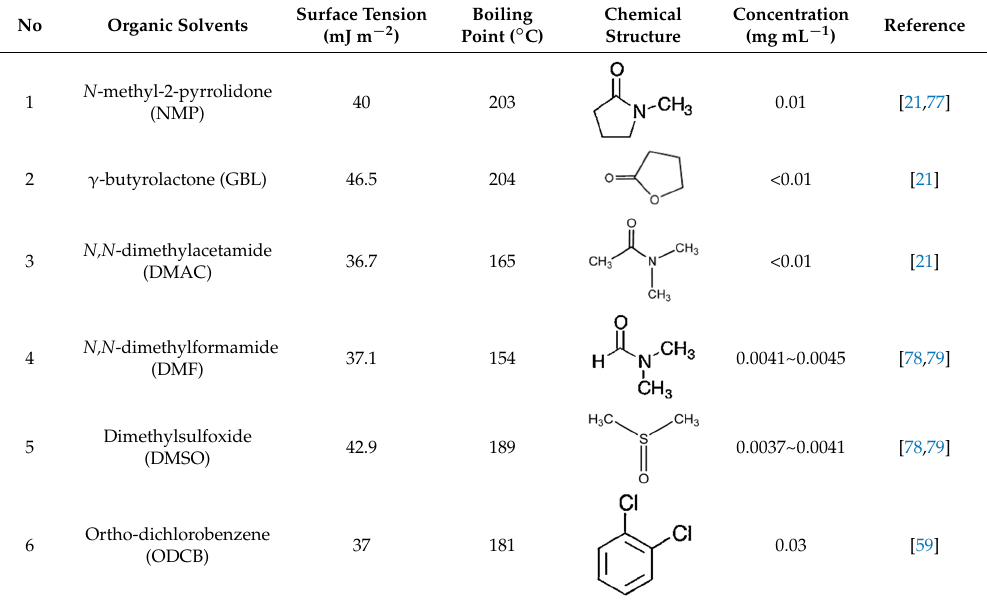
Table 4. Original organic solvents have been used to exfoliate graphene. Boiling Chemical Surface Tension Organic Solvents No Organic Solvents Point (°C) (mJ m − 2 )